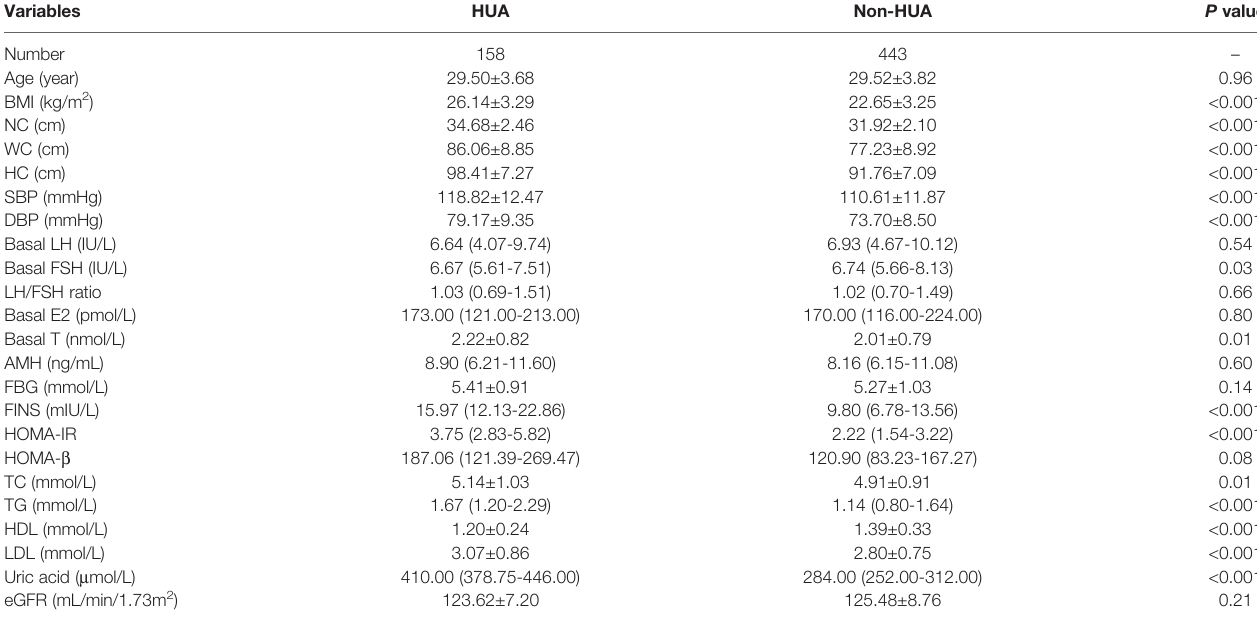
TABLE 1 | Baseline characteristics of women with PCOS.